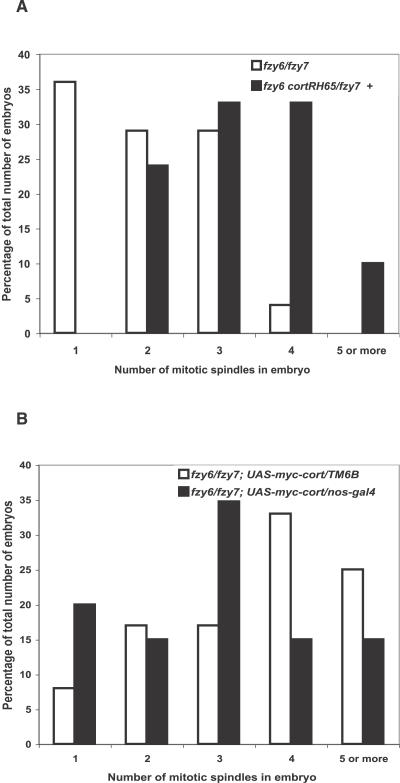

cort and fzy Genetically Interact in Early Embryos(A) cort dominantly suppresses the fzy female-sterile phenotype. Bar graph showing the percentage of 0–3-h embryos arresting with one, two, three, four, and five or more mitotic spindles. For fzy6/fzy7, n = 28. For fzy6 cortRH65/fzy7 +, n = 21. Analysis of the data with the Exact Wilcoxon Rank Sum Test generates a p-value of 3.43 × 10−5 when comparing the difference in the median number of mitotic spindles per embryo of fzy6/fzy7 and fzy6 cortRH65/fzy.(B) Overexpression of cort in the female germline enhances the fzy female-sterile phenotype. Bar graph showing the percentage of 2–4-h embryos arresting with one, two, three, four, and five or more mitotic spindles. For fzy6/fzy7; UAS-myc-cort/TM6B, n = 12. For fzy6/fzy7; UAS-myc-cort/nos-gal4, n = 20. Analysis of the data with the Exact Wilcoxon Rank Sum Test generates a p-value of 0.12 when comparing the difference in the median number of mitotic spindles per embryo of fzy6/fzy7; UAS-myc-cort/TM6B and fzy6/fzy7; UAS-myc-cort/nos-gal4.